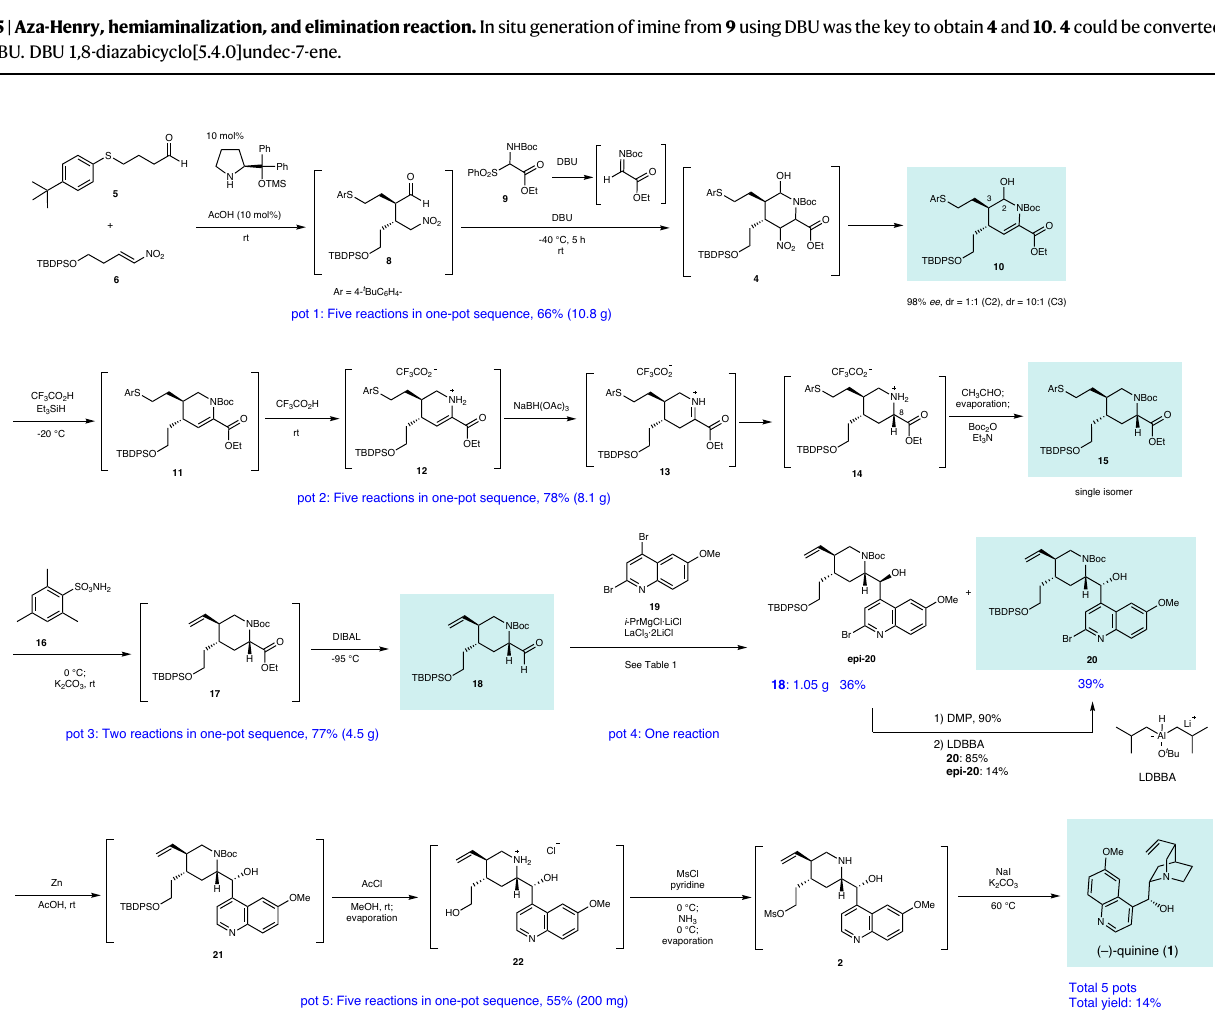
Total 5 pots pot 5: Five reactions in one-pot sequence, 55% (200 mg) Total yield: 14% Fig. 6 | Five-pot asymmetric synthesis of ( – )-quinine. Organocatalyst-mediated afforded ( – )-quinine ( 1 ). Ac acetyl, DIBAL diisobutylaluminium hydride, LDBBA lithium diisobutyl- tert -butoxyaluminum hydride, Ms methansulfonyl, Pr propyl. construction of the piperidine ring in one-pot. After two one-pot reaction and introductionofquinolinering,sequentialdeprotection,mesylationandcyclization